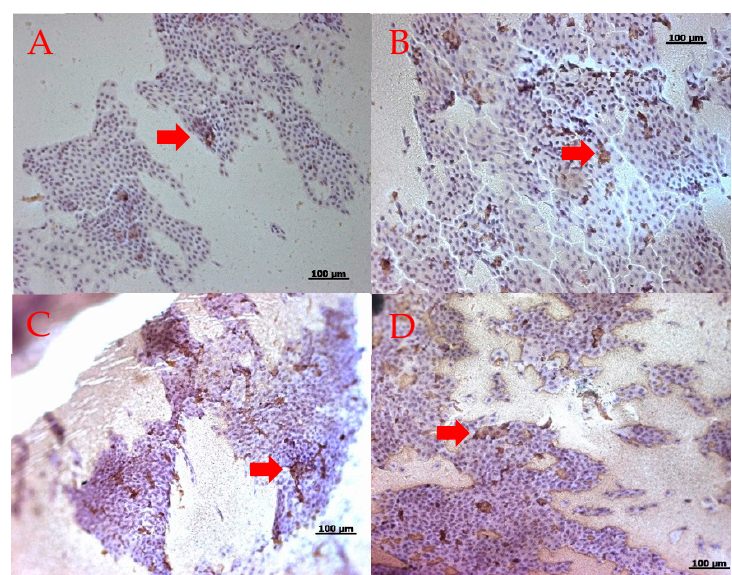
Figure 4. Representative MUC16 immunohistochemistry staining. Note the positive MUC16 staining before and after 1 month of eyewash use (red arrows): ( A ) baseline in group one; ( B ) after 1 month in group one; ( C ) baseline in group two; and ( D ) after 1 month in group two.